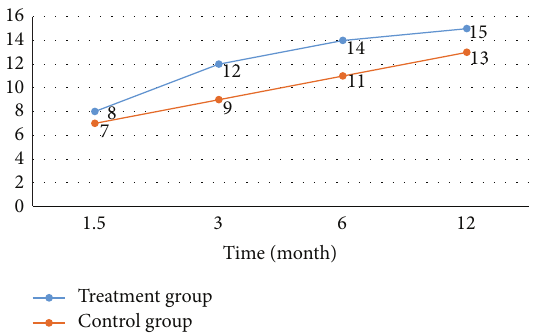
Figure 1: Intergroups changes on the Merle d’Aubign´e scores for 12 months.